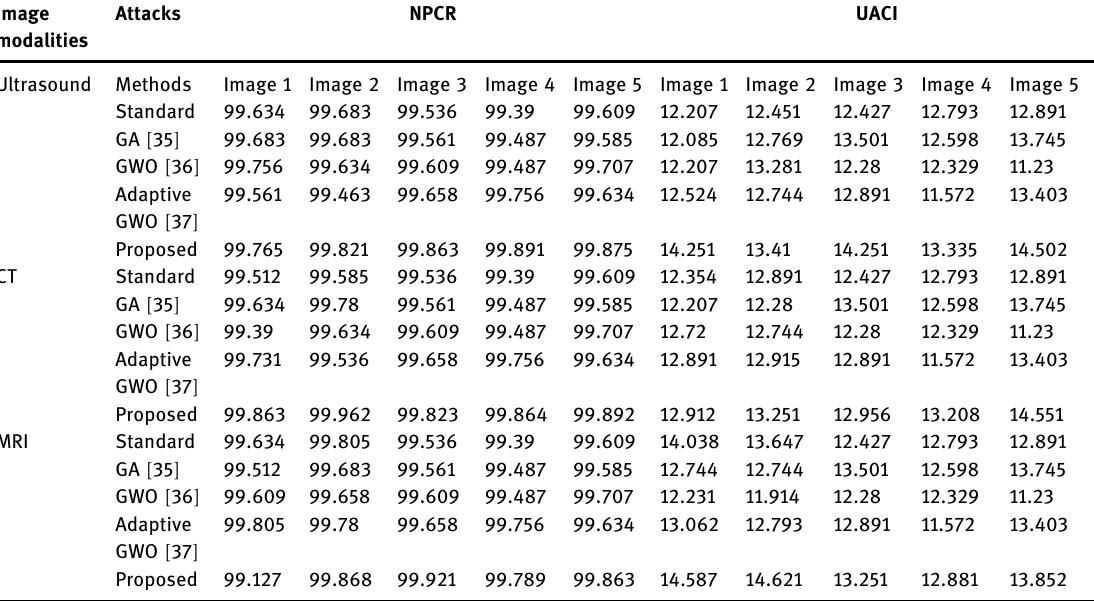
Table 6: NPCR and UACI analysis of ultrasound, CT, and MRI images Image